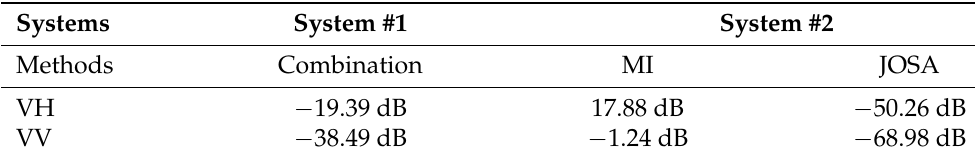
Table 4. Amplitude Intensity Ratio of Point Impulse